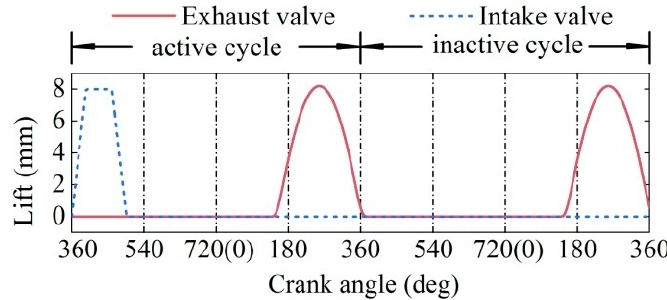
Figure 4. The schematic of the valve strategy based on low-pressure charge.